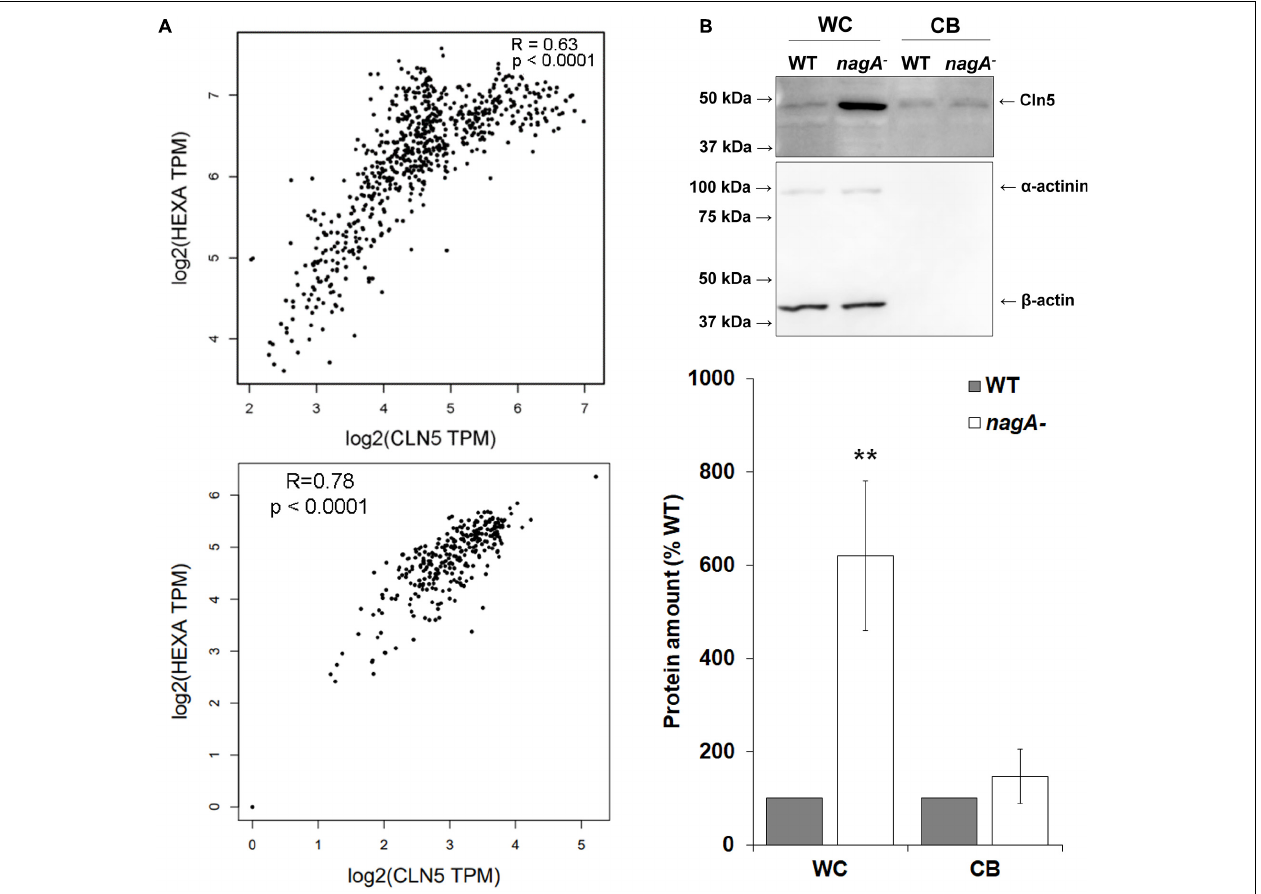
FIGURE 8 | Examining the link between CLN5/Cln5 and HEXA/NagA. (A) Co-expression of CLN5 and HEXA in human tissues. RNA sequencing data across 53 non-diseased tissue sites (8,587 samples) were collected from the GTEx Project, which is available on the GEPIA2 database (http://gepia.cancer-pku.cn/index.html). The correlation analysis tool on the GEPIA2 database was used to analyze the expression of CLN5 and HEXA in these samples (top). The correlation analysis tool was also used to analyze the expression of CLN5 and HEXA in a subset of samples from brain tissue (cerebellum, cortex, and hippocampus) (bottom). Pearson correlation statistics were calculated for each plot and the statistical significance for the correlations were determined. Transcripts per million (TPM). (B) Effect of nagA -deficiency on the intracellular and extracellular amounts of Cln5. Cells were starved for 4 h in KK2 buffer after which time the cells were lysed. Whole cell (WC) lysates (20 µ g) and samples of conditioned buffer (CB, 0.2 µ g) were separated by SDS-PAGE and analyzed by western blotting with anti-Cln5, anti-alpha-actinin (loading control), and anti-beta-actin (loading control). Molecular weight markers (in kDa) are shown to the left of the blot. Protein bands were quantified and standardized to the levels of alpha-actinin and beta-actin. Raw values were then expressed as a percentage of the amount of Cln5 in WT WC lysates and CB. Data presented as mean amount of protein (% WT) ± SEM ( n = 7). Statistical significance was determined using the one sample t -test. ** p -value < 0.01 vs.